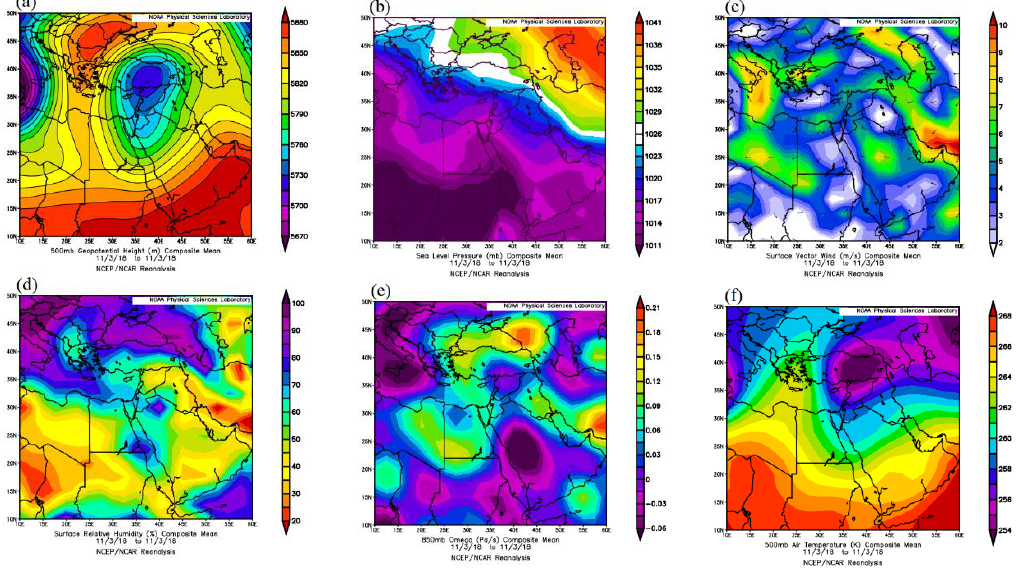
Figure 6: The weather chart for 3 November 2018, (a) 500 mb geopotential height (m), (b) sea level pressure (mb), (c) surface wind (m/s), (d) surface relative humidity (%),